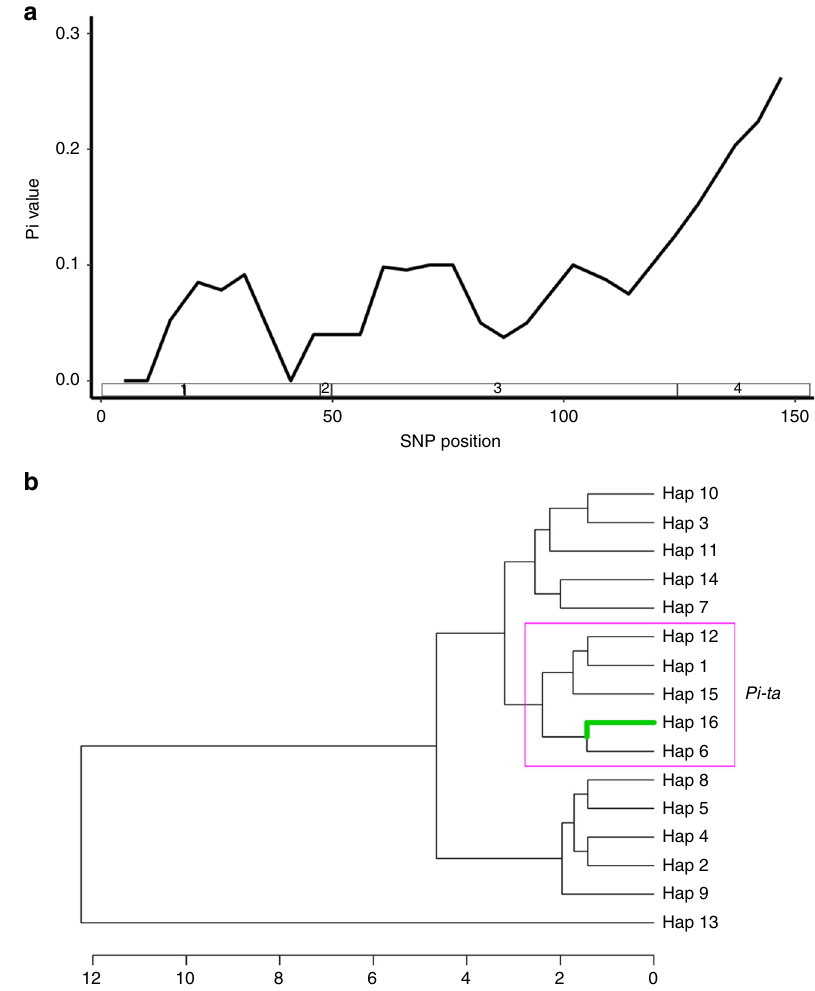
Fig. 5 DNA sequence polymorphism of Ptr in 3 K rice germplasm. a Sliding window analysis of polymorphism with SNPs from indicated coding regions showed in the bars. x -axis is the total number for SNPs in exons. b Phylogenetic tree of each haplotype (Hap) in supplementary Table 7. Hap 16 has an identical Ptr sequence as Katy. Hap 1, Hap 6, Hap 12, Hap 15, and Hap 16 grouped in the pink rectangle contain the identical resistant Pi-ta allele in Katy (see Supplementary Data 2 for information on rice varieties for each haplotype and details of SNPs). Evolutionary distance is as indicated on x